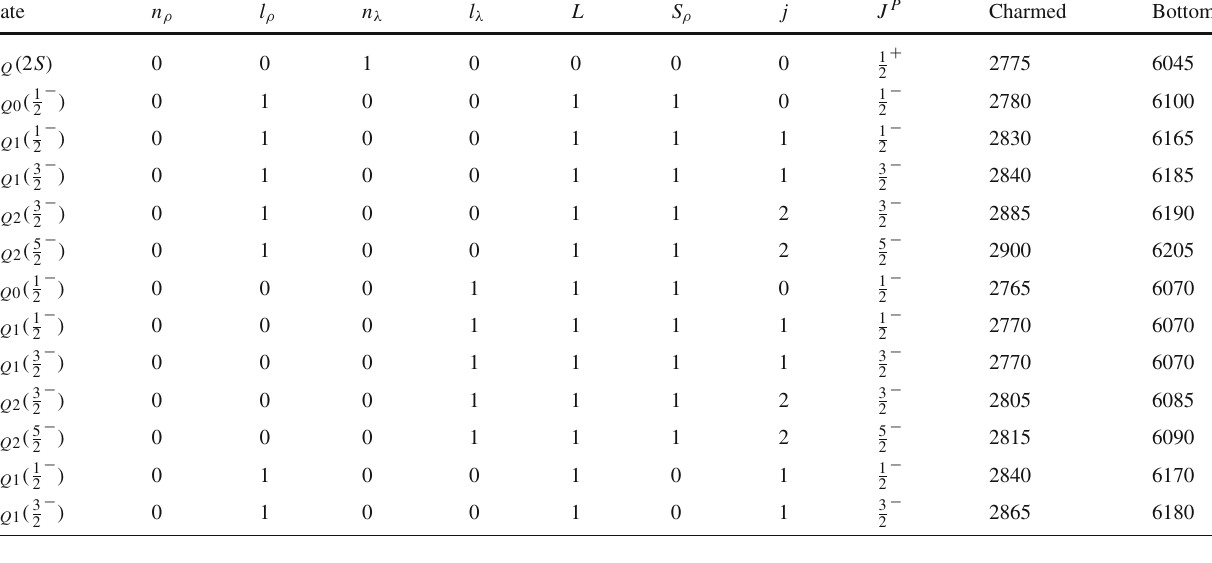
Table 1 Notations, quantum numbers and masses of the initial baryons. The masses are taken from the relativized quark model [31]. The Q stands for a charm or bottom quark, and the ∼ is used for the ρ -mode states. The units are inMeV